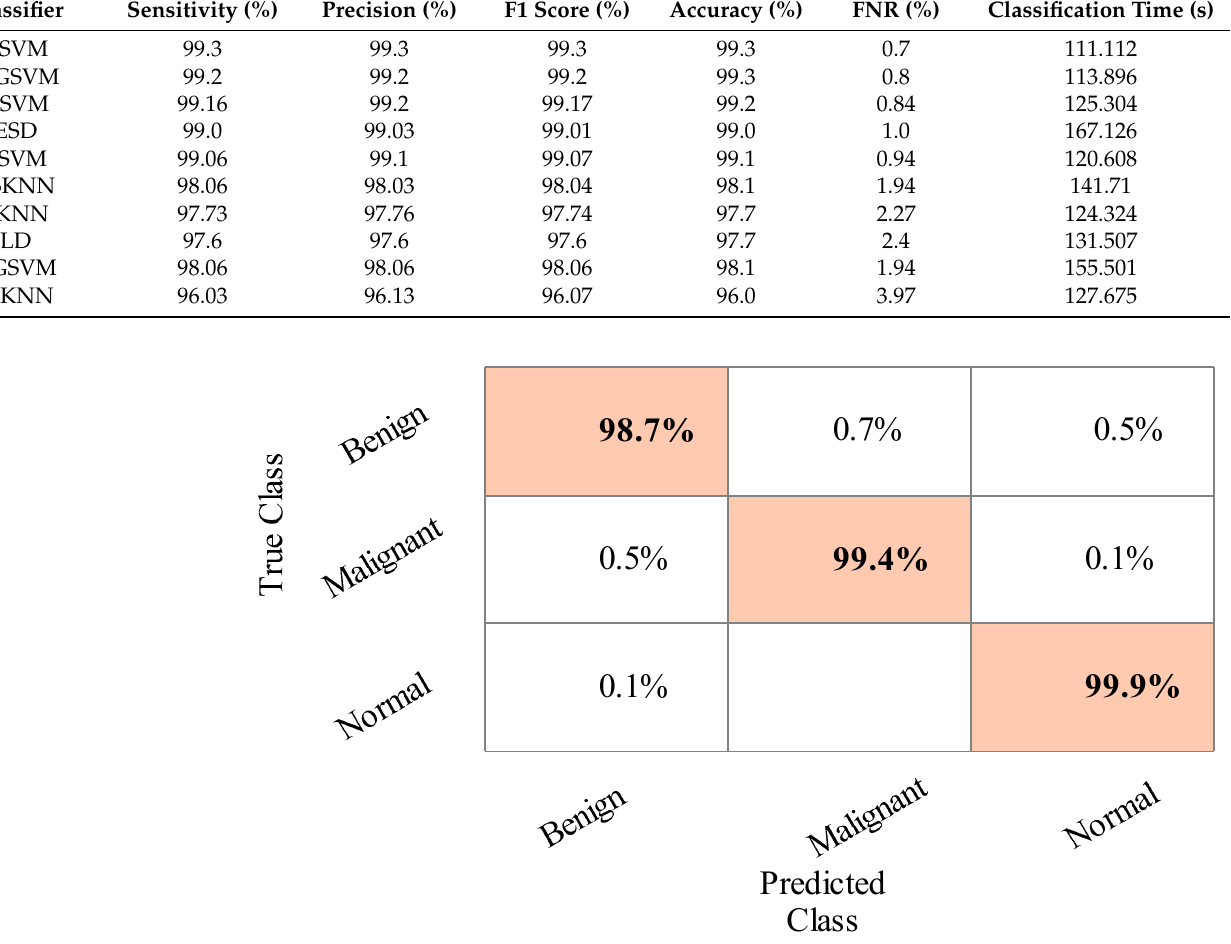
Figure 7. Confusion matrix of Cubic SVM for training/testing ratio of 70:30.